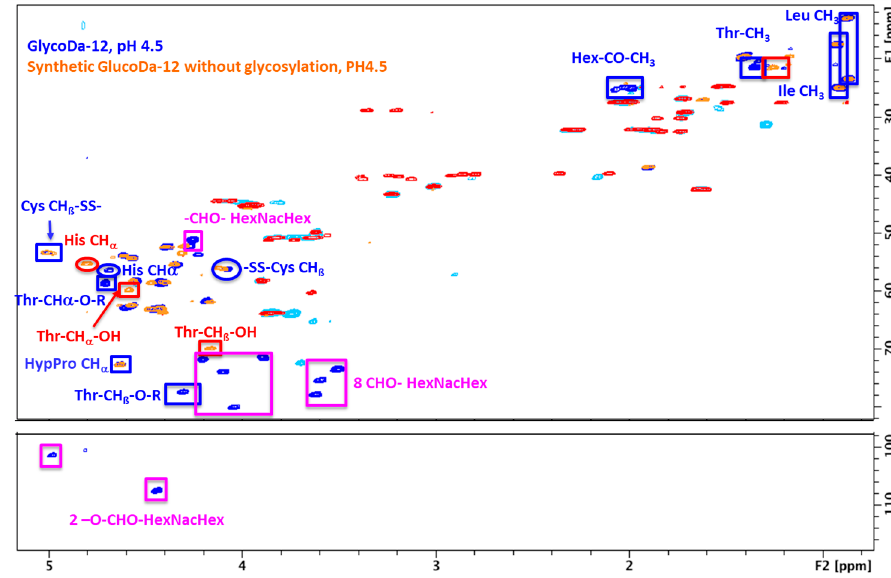
Figure 7. Edited 13 C– 1 H HSQC: overlay of the natural extract GlycoDa-12 (CH, CH 3 : blue/CH 2 : cyan) and the synthesized peptide with cysteine oxidized (CH, CH 3 : orange/CH 2 : red). The methyl signal for threonine, NAcetyl hexose, leucine, and isoleucine are indicated in blue boxes. The 10 hexose CH are observed in pink boxes. CH α for the two cysteines, the histidine, the hydroxyl-proline, and the threonine are labeled.